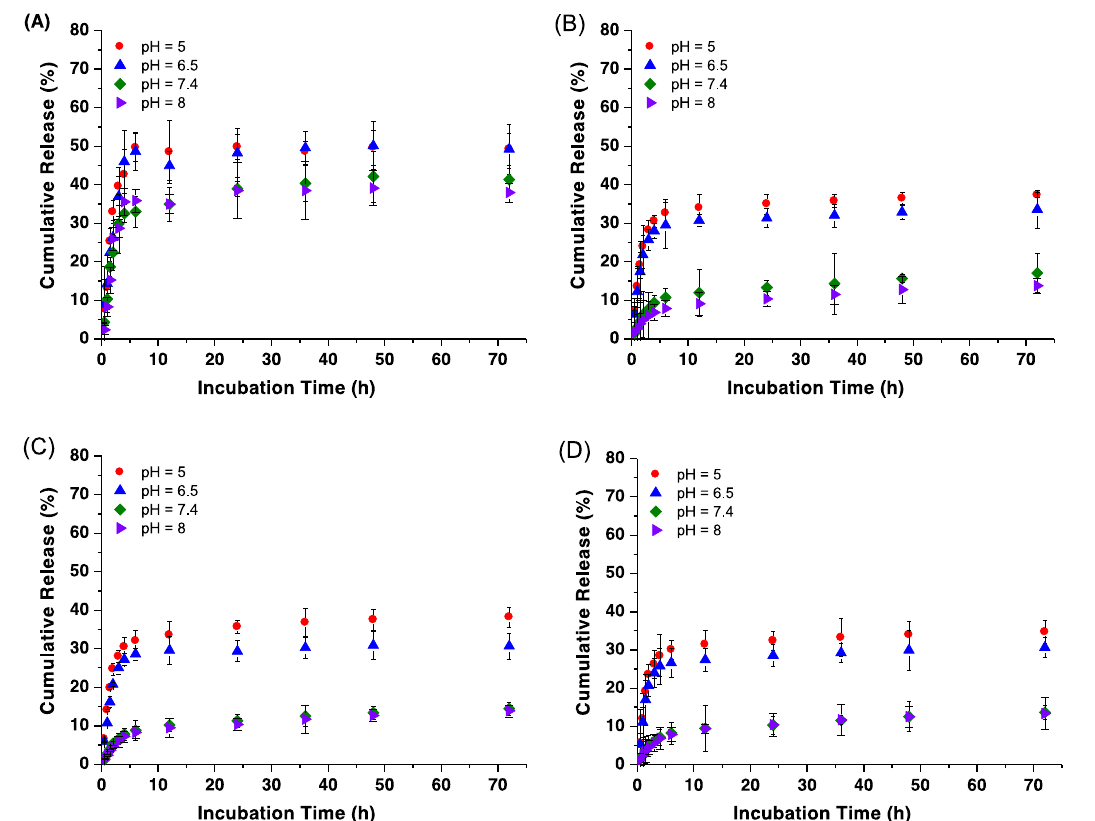
Figure 6. Drug release profiles of doxorubicin (DOX) loaded in ( A ) MSN-Br, ( B ) MSN-PDEAEMA, ( C ) MSN-PDEAEMA-Cys, and ( D ) MSN-PDEAEMA-Cys-POEGMEMA nanocarriers with different pH values at 37 °C.